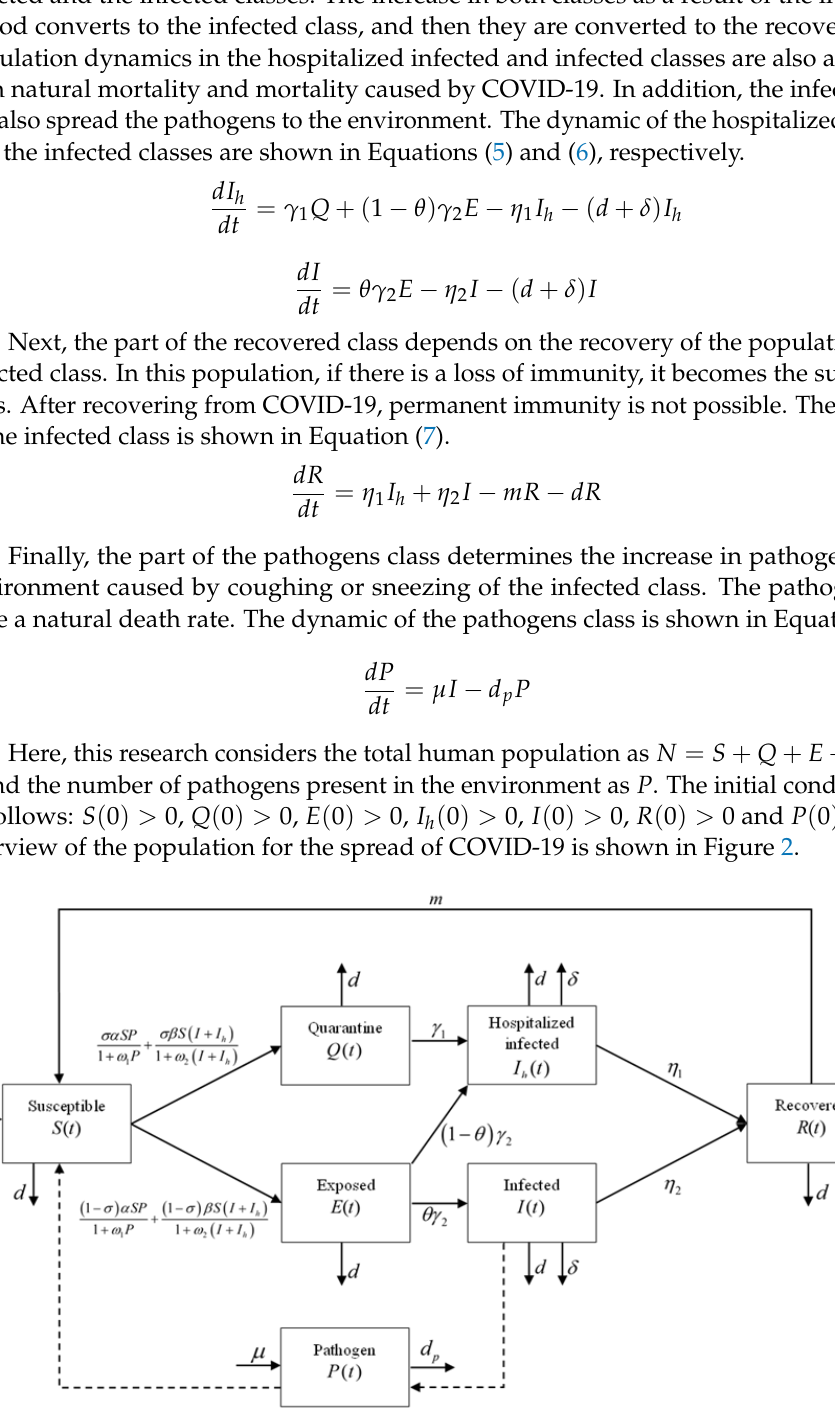
Figure 2. The SQEIRP mathematical model for the COVID-19 epidemic. The parameters and parameter descriptions of the SQEIRP model are shown in Table